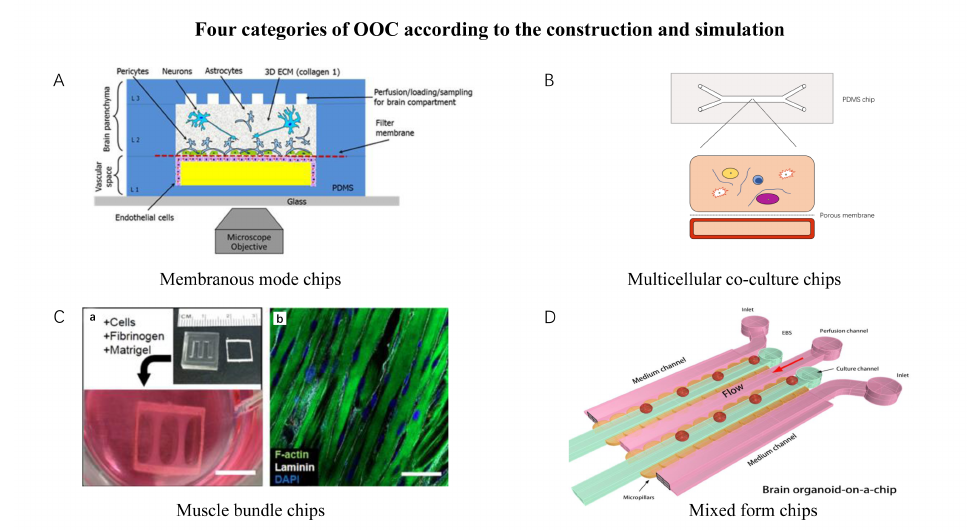
Figure 3. Four OOC models correspond to four types of simulation modes. ( A ) Blood–brain barrier chip, a representative of membrane mode chip (adapted and modified from [21]). ( B ) Schematic diagram of multicell culture in PDMS chip. ( C ) Human myogenic precursors were cultured in the nylon chip, a representative of a muscle bundle chip (adapted and modified from [30]). ( D ) Brain organoids-on-a-chip, a representative of mix form